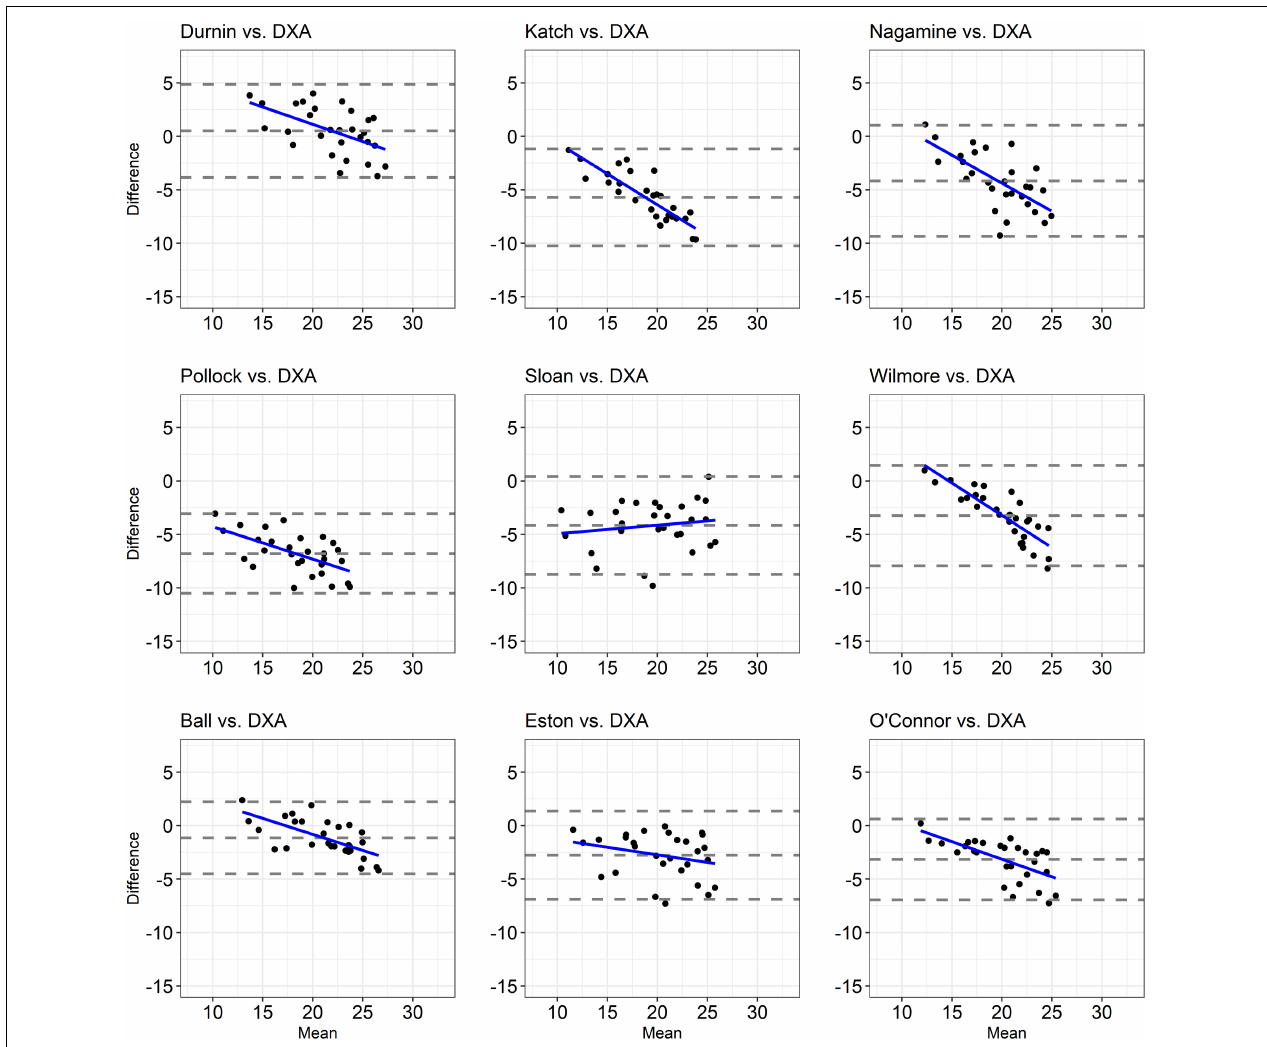
FIGURE 2 | Bland-Altman Plots showing the agreement between the %FM assessed through anthropometric equations validated upon able-bodied non-athletic populations and the %FM DXA . The dashed lines indicate bias ± 2 standard deviations and the solid blue line indicates the regression